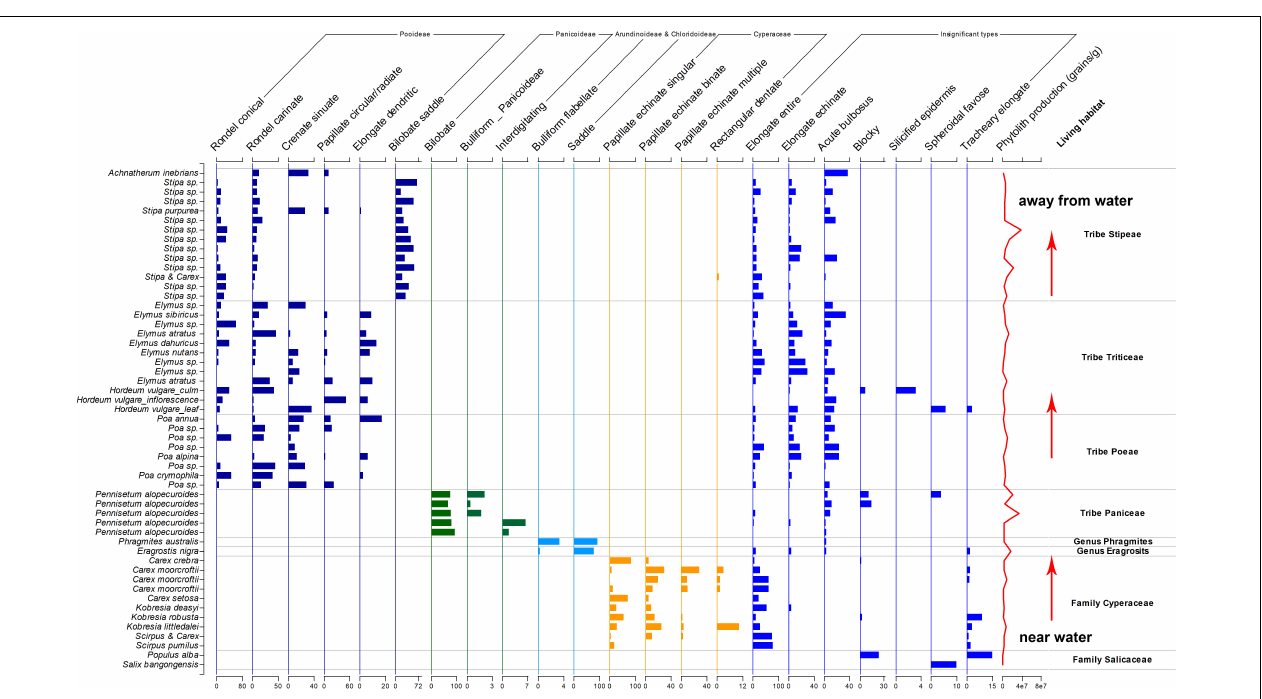
FIGURE 6 | Phytoliths assemblages in studied